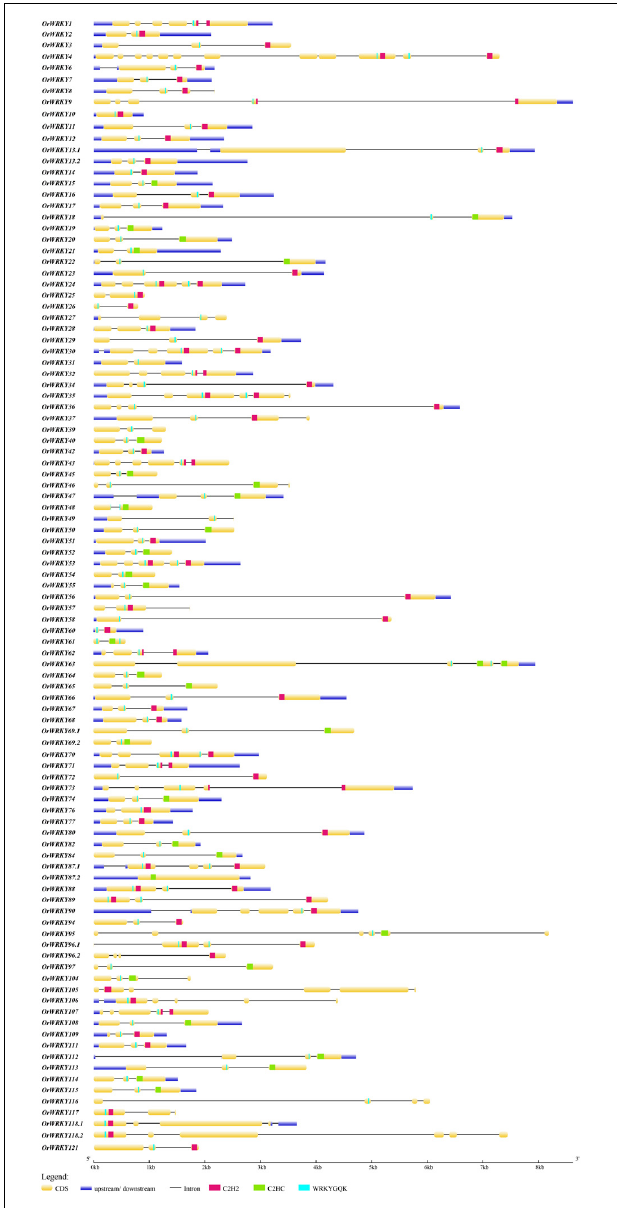
FIGURE 1 | The exon–intron structures of OrWRKY genes. The exons and introns are indicated by yellow rectangles and black lines, respectively. The untranslated regions (UTRs) are indicated by blue rectangles. The WRKY motifs are represented by light blue vertical bars. The C2H2 zinc fingers are represented by red bars. The C2HC zing fingers are represented by green